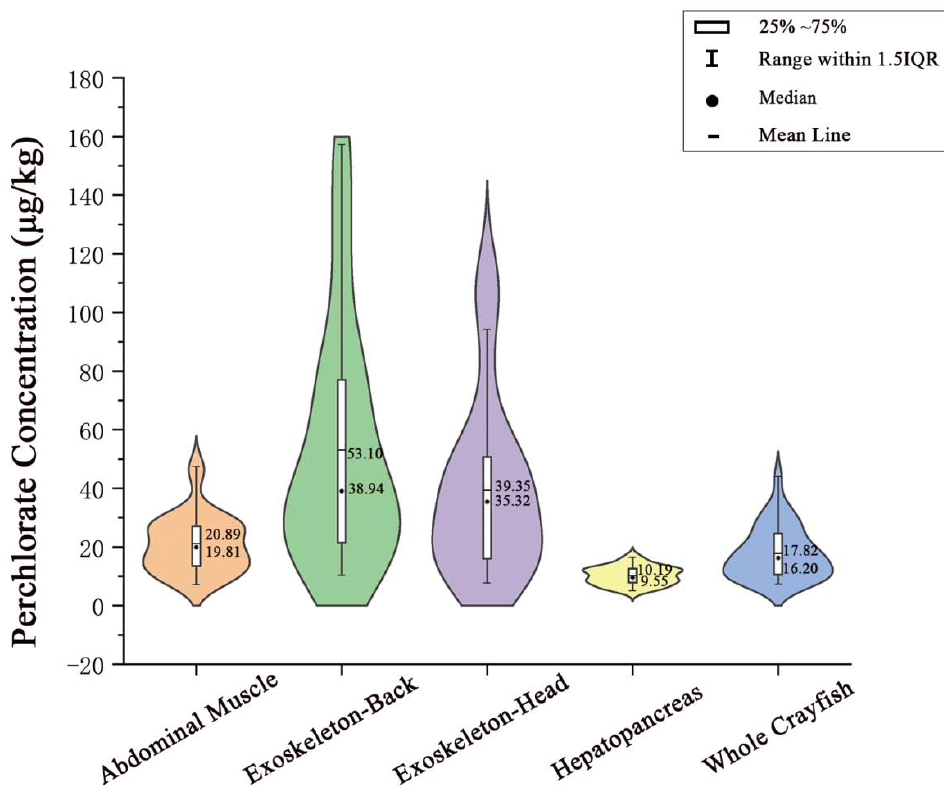
Figure 3. Perchlorate concentration in different tissues of crayfish.